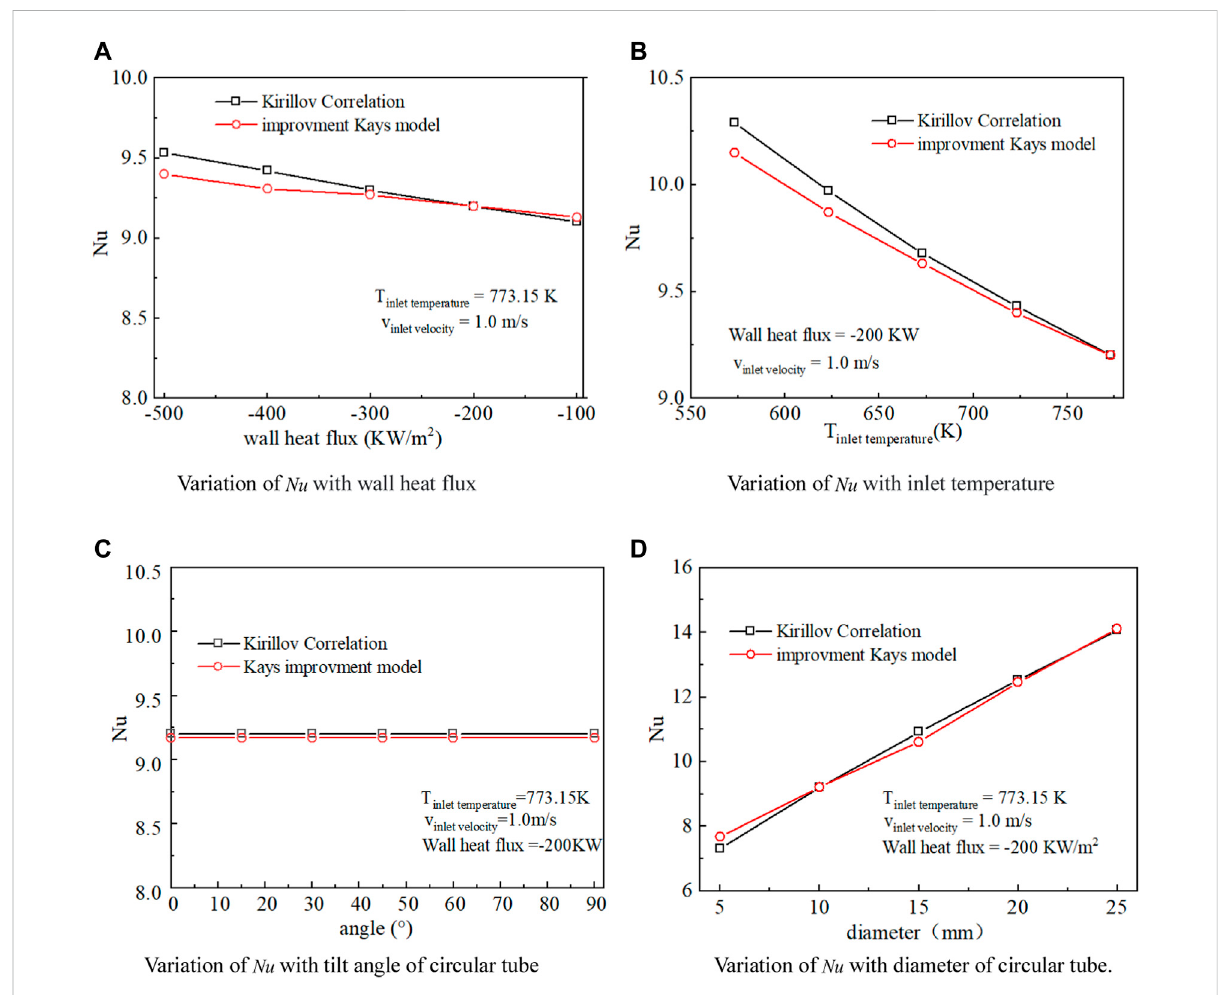
FIGURE 6 Variation of Nu with wall heat fl ux, inlet temperature, tilt angle and diameter.